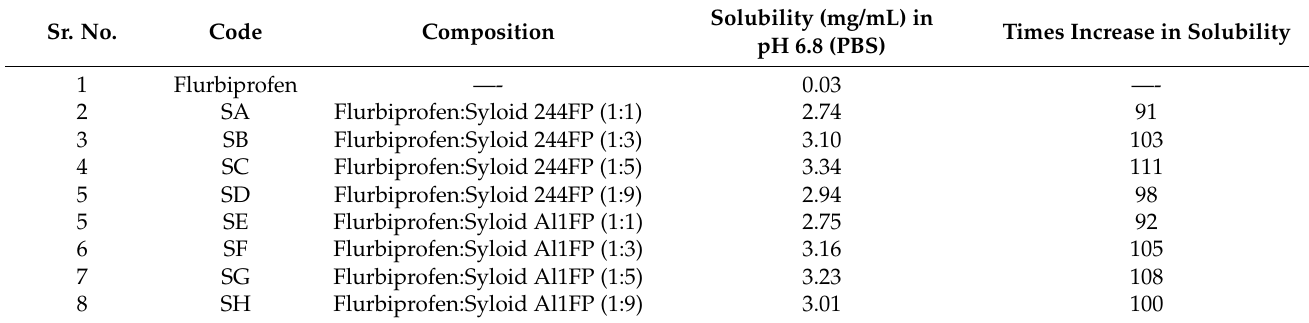
Table 2. Preformulation studies for selection of flurbiprofen silica